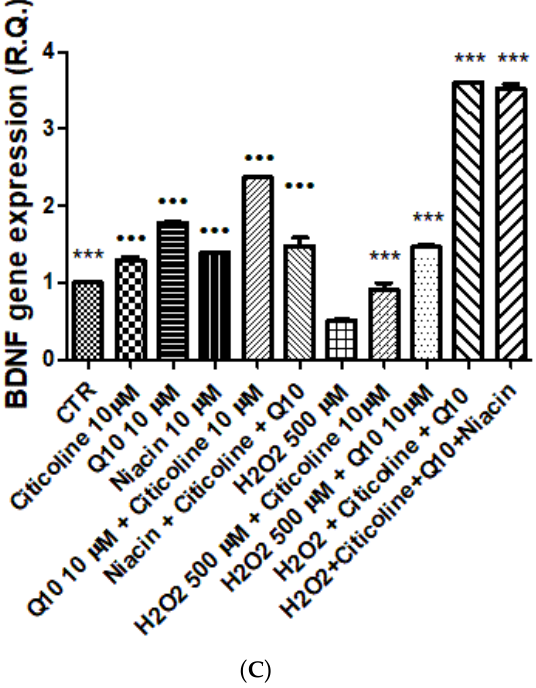
Figure 2. Effects induced by citicoline, niacin (vitamin B3), and coenzyme Q10 and the fixed combination on tumor necrosis factor- α (TNF α ) ( A ), interleukin-6 (IL-6) ( B ), and brain-derived neurotrophic factor (BDNF) ( C ) gene expression, in isolated hypothalamic specimens exposed to hydrogen peroxide. ANOVA, p < 0.0001; *** p < 0.001 vs. control (CTR) group, … p <0.001 vs. H 2 O 2 . The concomitant stimulation of BDNF gene expression and the reduced gene expression of both IL-6 and TNF α indicate neuroprotective properties by the single ingredients and their association. The latter is more effective in stimulating BDNF gene expression, compared with the single ingredients.